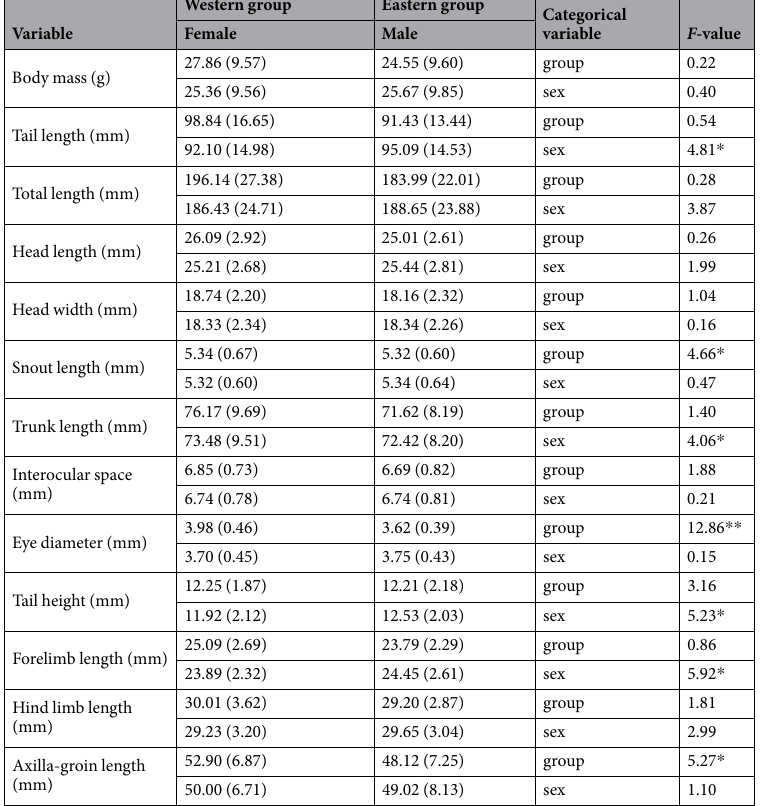
Table 3. A comparison of morphological features of B . tibetanus from the Qinling Mountains (analysis of covariance) ( * P < 0.05; ** P < 0.01). The dataset contained 35 individuals from the western group and 85 from the eastern group, according to the population group determined by the Spatial Analysis of Molecular Variance (SAMOVA). The measurements of morphological features in this table were mean values and standard